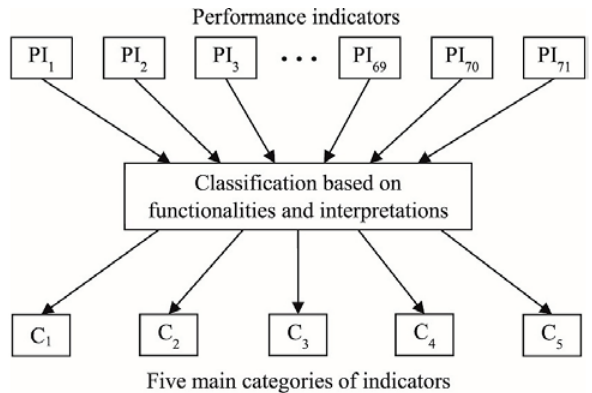
Fig. 4. classification framework of